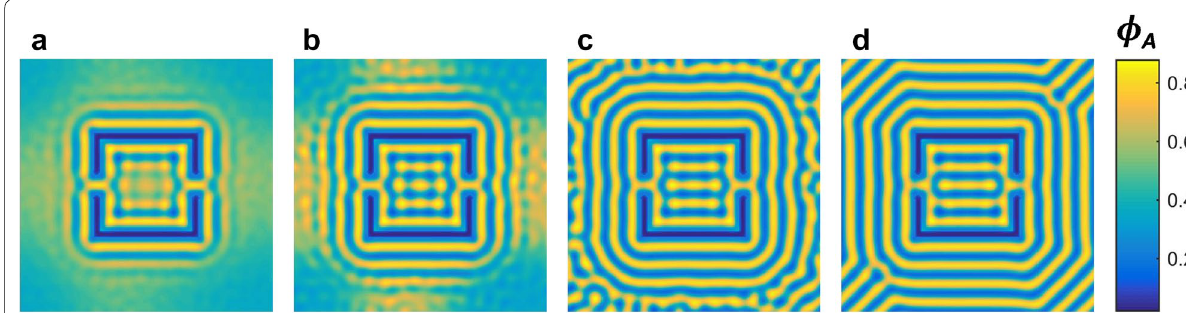
Fig. 4 SCFT simulations showing the evolution of the polymer self‑assembled pattern. a Early stages of the simulation show a wetting layer is formed of the inner and outer surface of the walls while the polymer is still disordered in the region surrounding the template. A junction is formed at every opening in the template wall, connecting the inner and outer wetting layers. b An ordering front is propagating away from the walls creating a series of concentric squares. Polymer microdomains are nucleated adjacent to the bends in the inner wetting layer caused by the opening in the walls. c Bridging of the polymer domains creates a horizontal stripe between the two openings. d Final polymer self‑assembled pattern reaches 0 state as shown